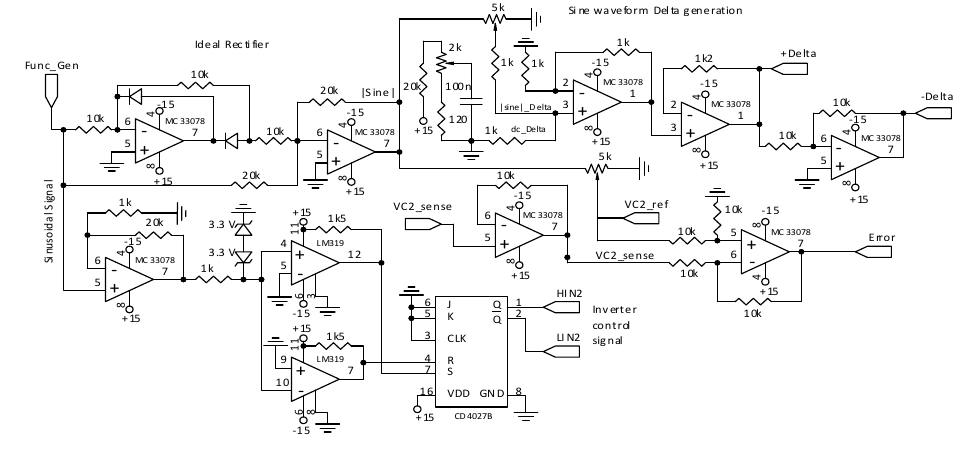
Figure 21. Generator of ancillary signals.